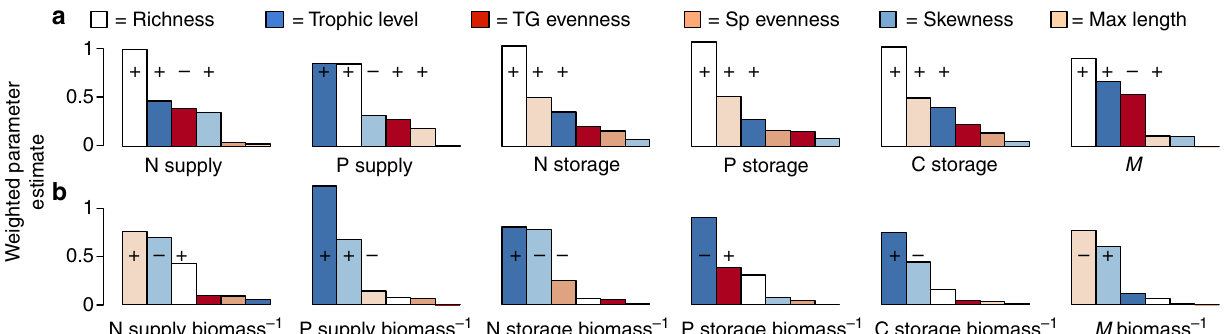
Figure 1 | The relative importance of different aspects of community structure for fish nutrient capacity. ( a ) Bars indicate mean weighted parameter estimates (for models with D AIC o 5) for mixed-effects model (with random intercepts for reef type and site nested within country; n ¼ 110) for six nutrient processes and M (multifunctionality). All models included six parameters: species richness (richness), species evenness (SD–reciprocal Simpson’s index), Trophic Group evenness (TG), mean biomass-weighted trophic level (TL), mean maximum size per species (Max Length) and skewness of the size frequency distribution of the community (Skewness). Colours denote the different parameters of interest. ‘ þ ’ or ‘ (cid:2) ’ distinguish the direction of the response for parameters that were within the top model and for which the 95% confidence intervals do not overlap zero. ( b ) Mean weighted parameter estimates (for models with D AIC o 5) for the same processes as in panel ( a ), but here corrected for relative biomass ( n ¼ 110). NATURE COMMUNICATIONS|7:12461|DOI: